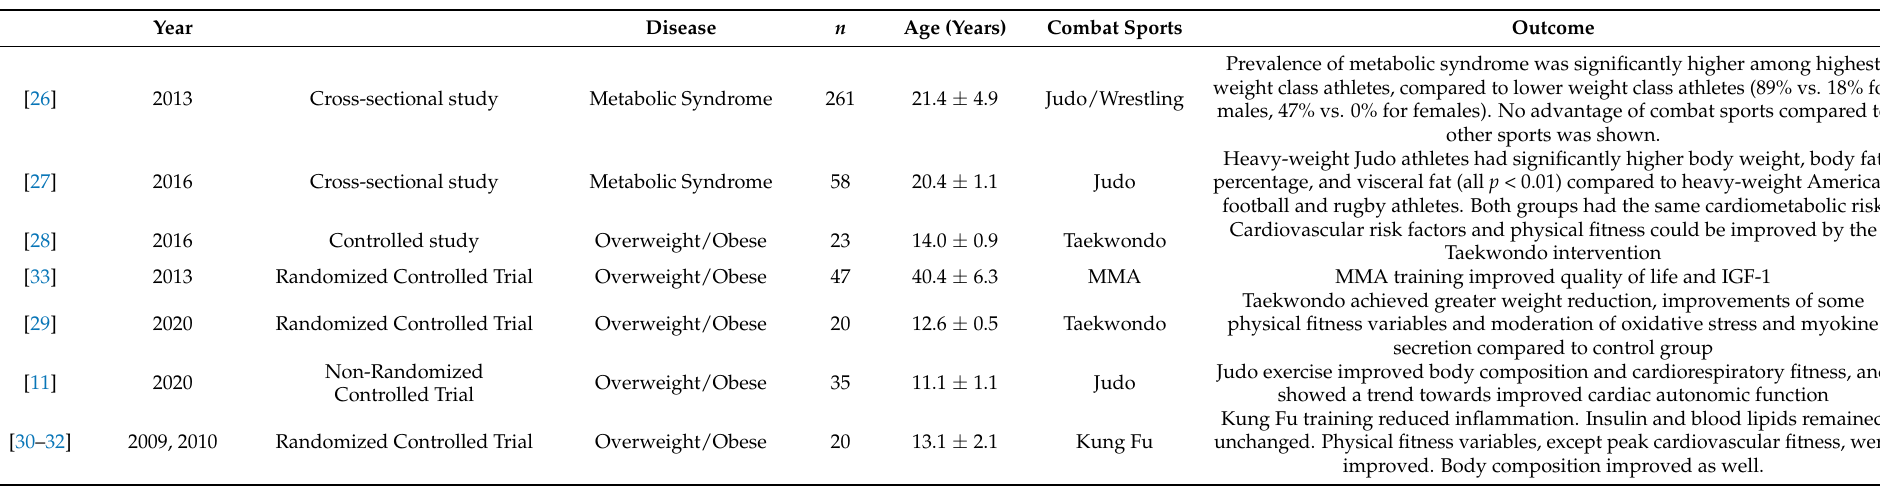
Table 2. Study characteristics of clinically diagnosed obesity and metabolic syndrome and combat